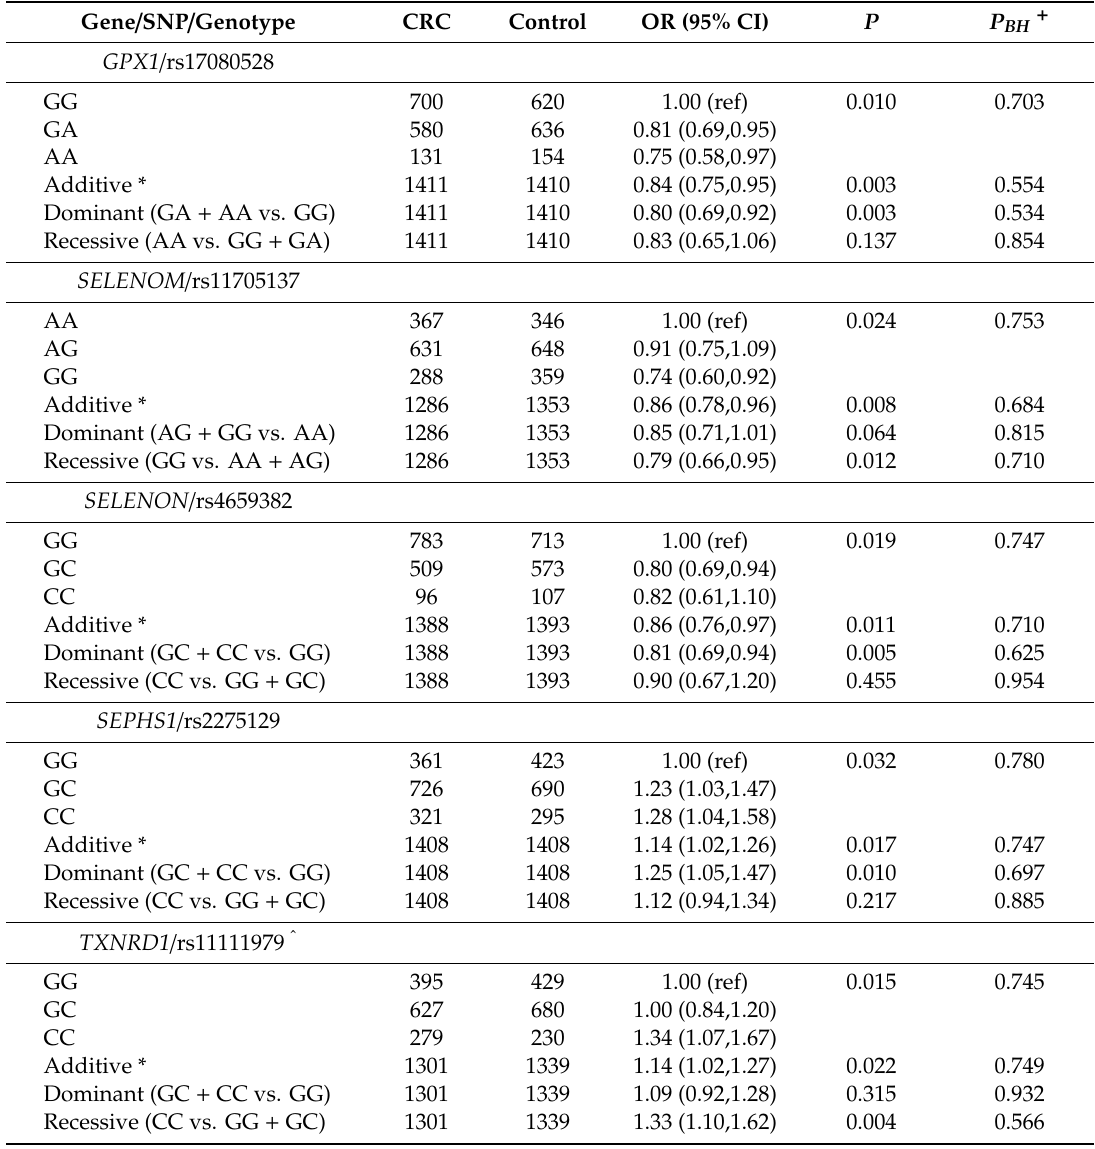
Table 2. Single nucleotide polymorphisms (SNPs) associated with colorectal cancer (CRC) risk in primary selenium pathway 1 (selenium and selenoprotein transport, biosynthesis and metabolism) with raw P -values < 0.01 in at least one genetic model prior to multiple testing adjustment, the EPIC study,